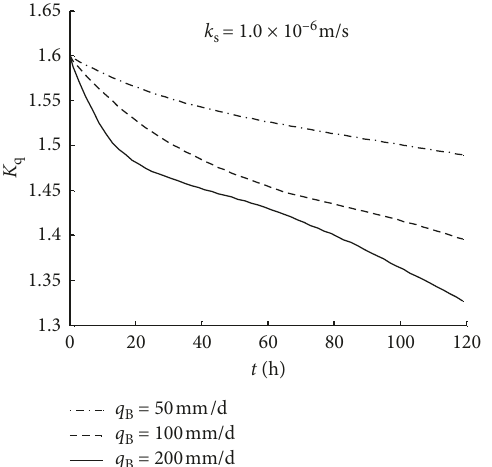
Figure 3: Effect of rainfall intensity on safety coefficient.